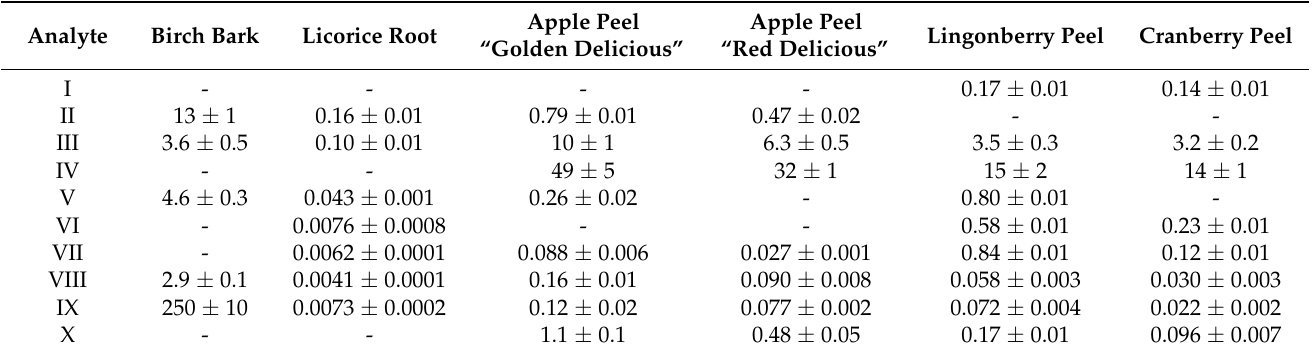
Table 3. The content of PCTs (mg · g –1 , recalculated for the oven-dried plant material) in plant tissues ( n = 3, p =